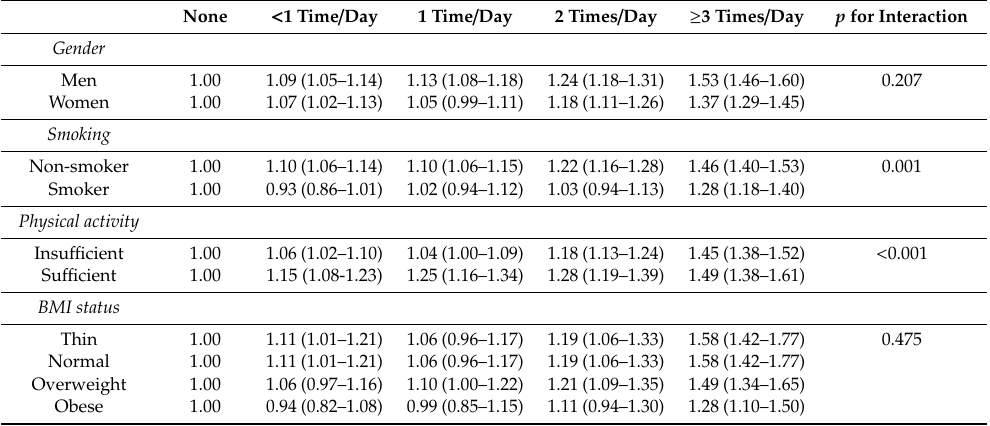
Table 3. Association between soft drink consumption and aggressive behavior by gender, smoking, and physical and BMI status 1